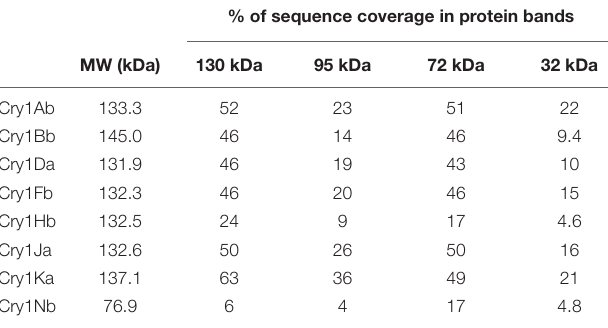
TABLE 4 | Proteomic analysis of B. thuringiensi s GR007 crystal composition.